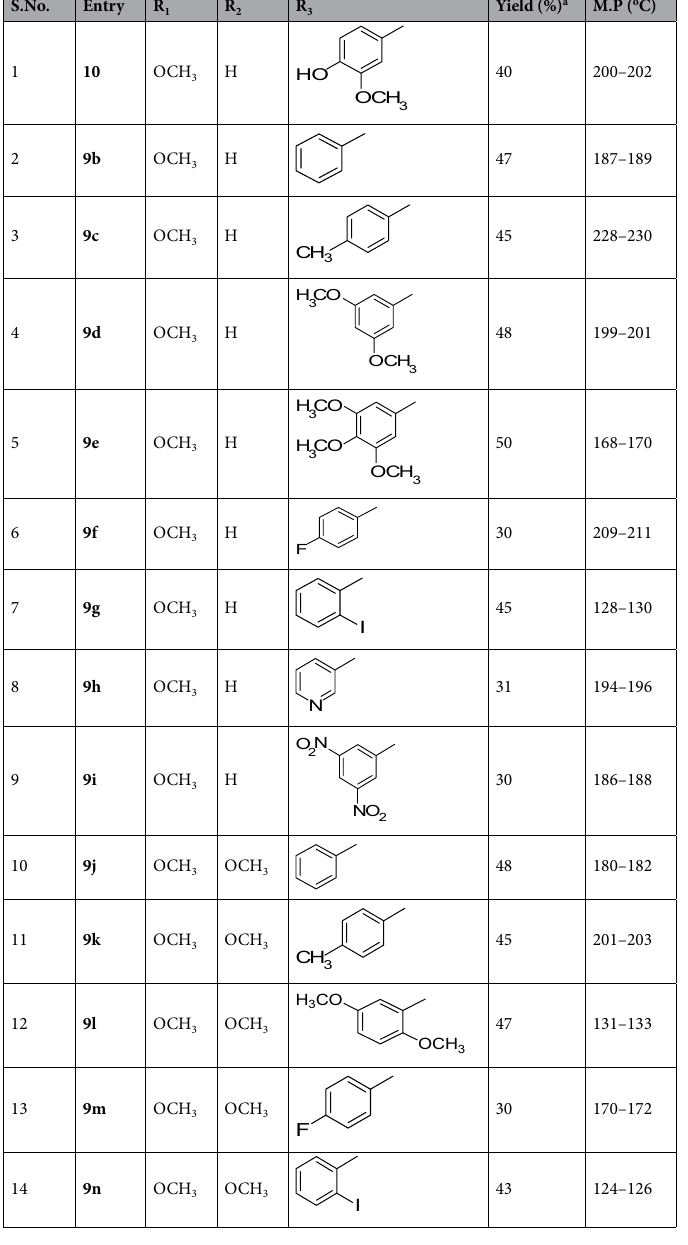
Table 1. Synthesis of saccharumoside-B and its analogs. a Isolated